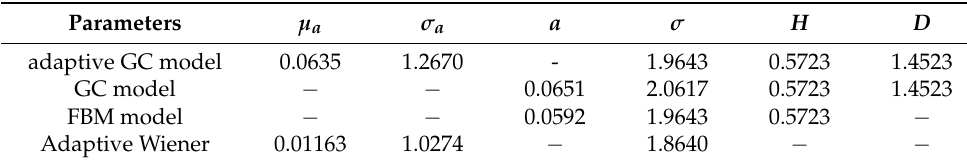
Table 4. Parameters Estimation of Different Prediction